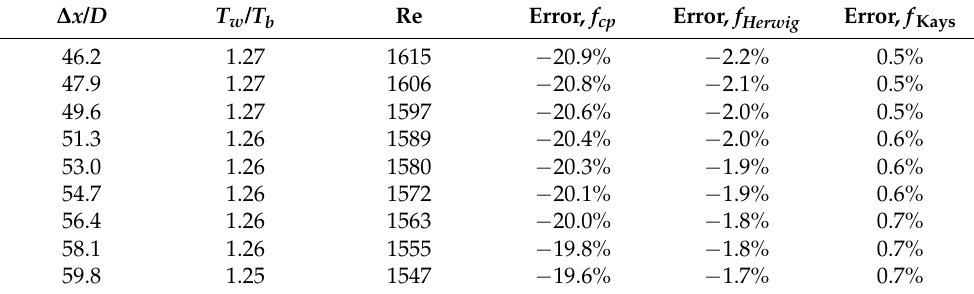
Table 4. Calculation errors of helium by laminar flow f correlations.